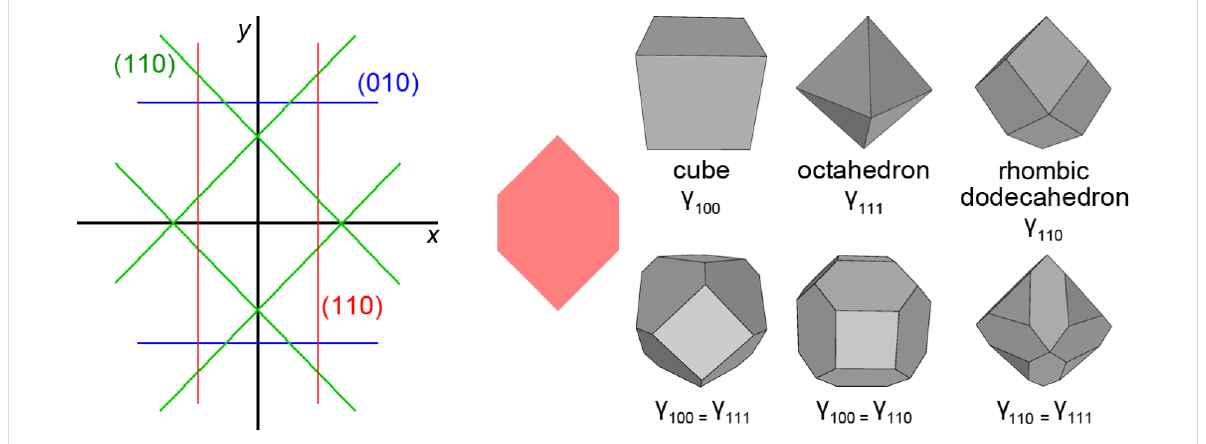
Figure 1: Left: Example of Wulff construction for orthorhombic material. xy plane is parallel to the (001) plane of the material. Center: The cross- section of the resulting equilibrium shape. Right: Some common Wulff constructions for materials with full cubic symmetry ( O h or ), such as fcc metals. The surface energies that have been used in the Wulff construction are shown below each